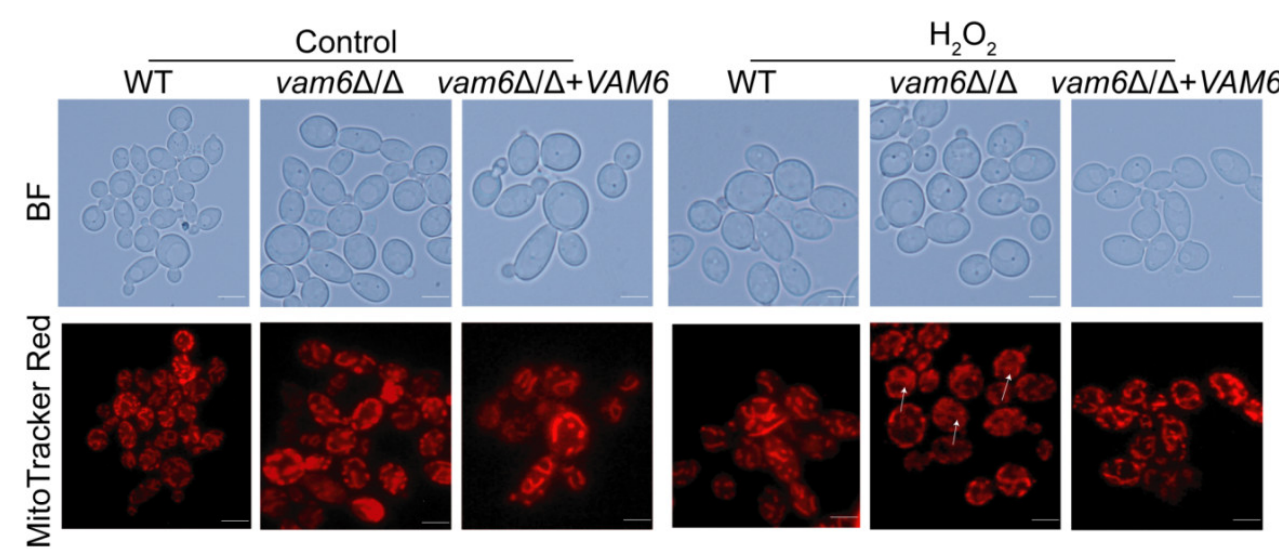
Figure 4. Deletion of VAM6 impairs mitochondrial morphology under Mitochondrial morphology was abnormal under oxidative stress. Fluorescence microscopy images of the strains stained by MitoTracker Red. The cells were cultured in liquid YPD containing 5 mM H 2 O 2 or not, stained, and observed. Bar = 5 μm.